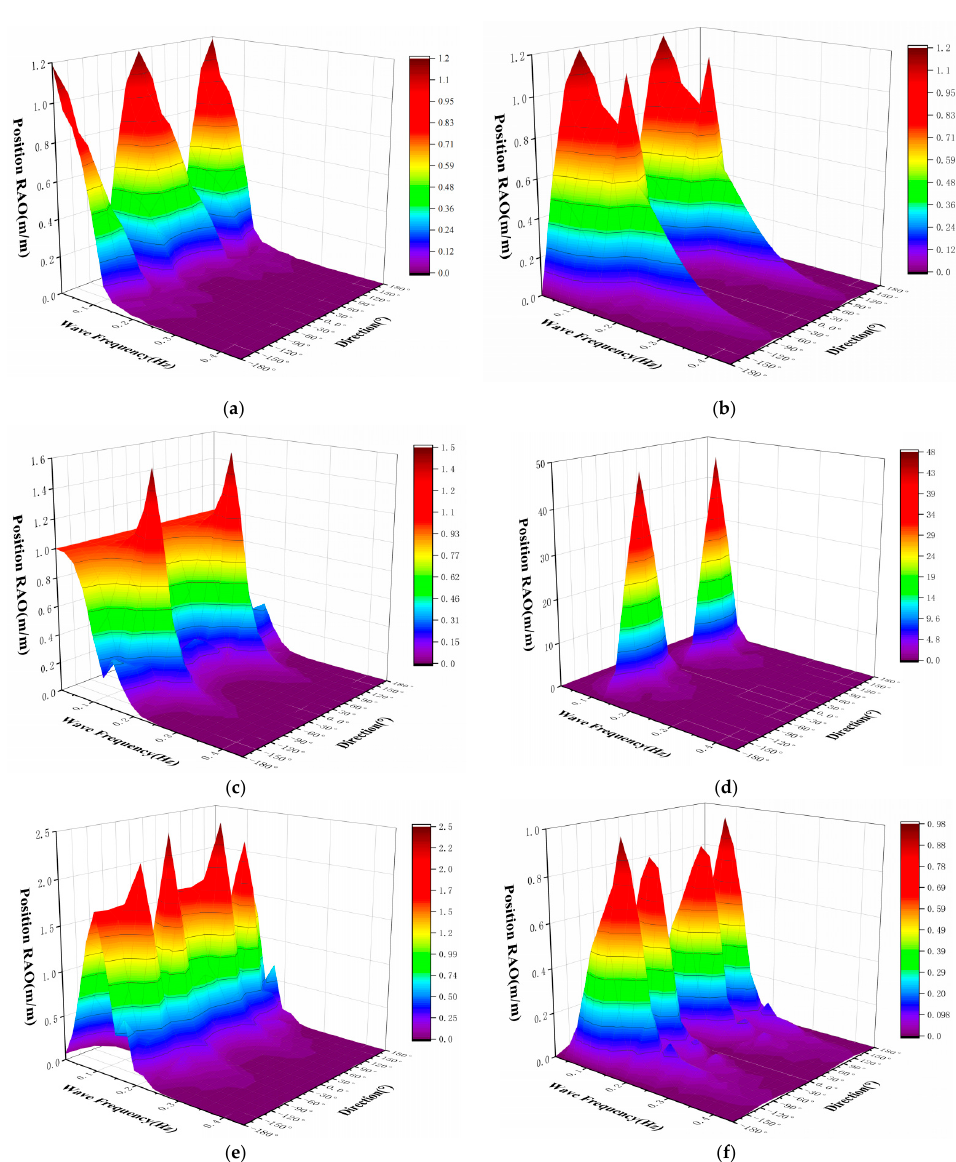
Figure 8. Motion response results of six directions (RAO): ( a ) surge (RAO); ( b ) sway (RAO); ( c ) heave (RAO); ( d ) roll (RAO); ( e ) pitch (RAO); ( f ) yaw (RAO).